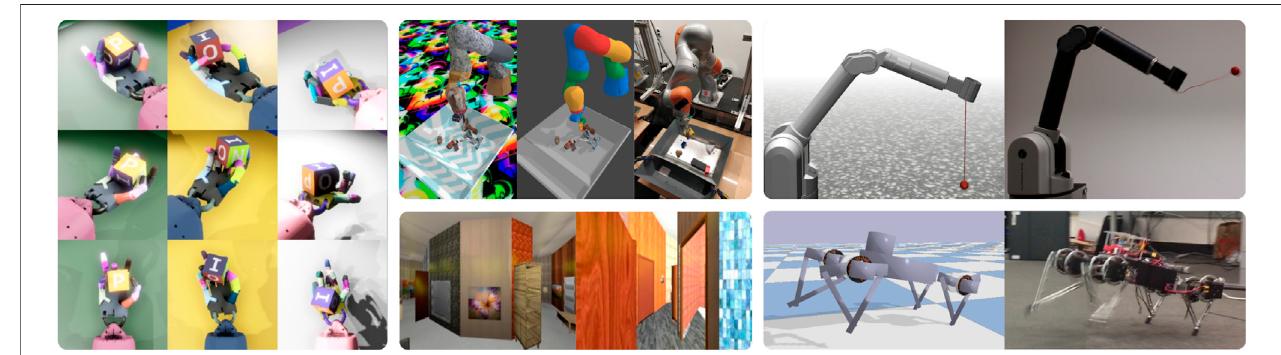
FIGURE 1 | Examples of sim-to-real robot learning research using domain randomization: (left) Multiple simulation instances of robotic in-hand manipulation (OpenAI et al., 2020), (middle top) transformation to a canonical simulation (James et al., 2019), (middle bottom) synthetic 3D hallways generated for indoor drone fl ight (Sadeghi and Levine, 2017), (right top) ball-in-a-cup task solved with adaptive dynamics randomization (Muratore et al., 2021a), (right bottom) quadruped locomotion (Tan et al.,